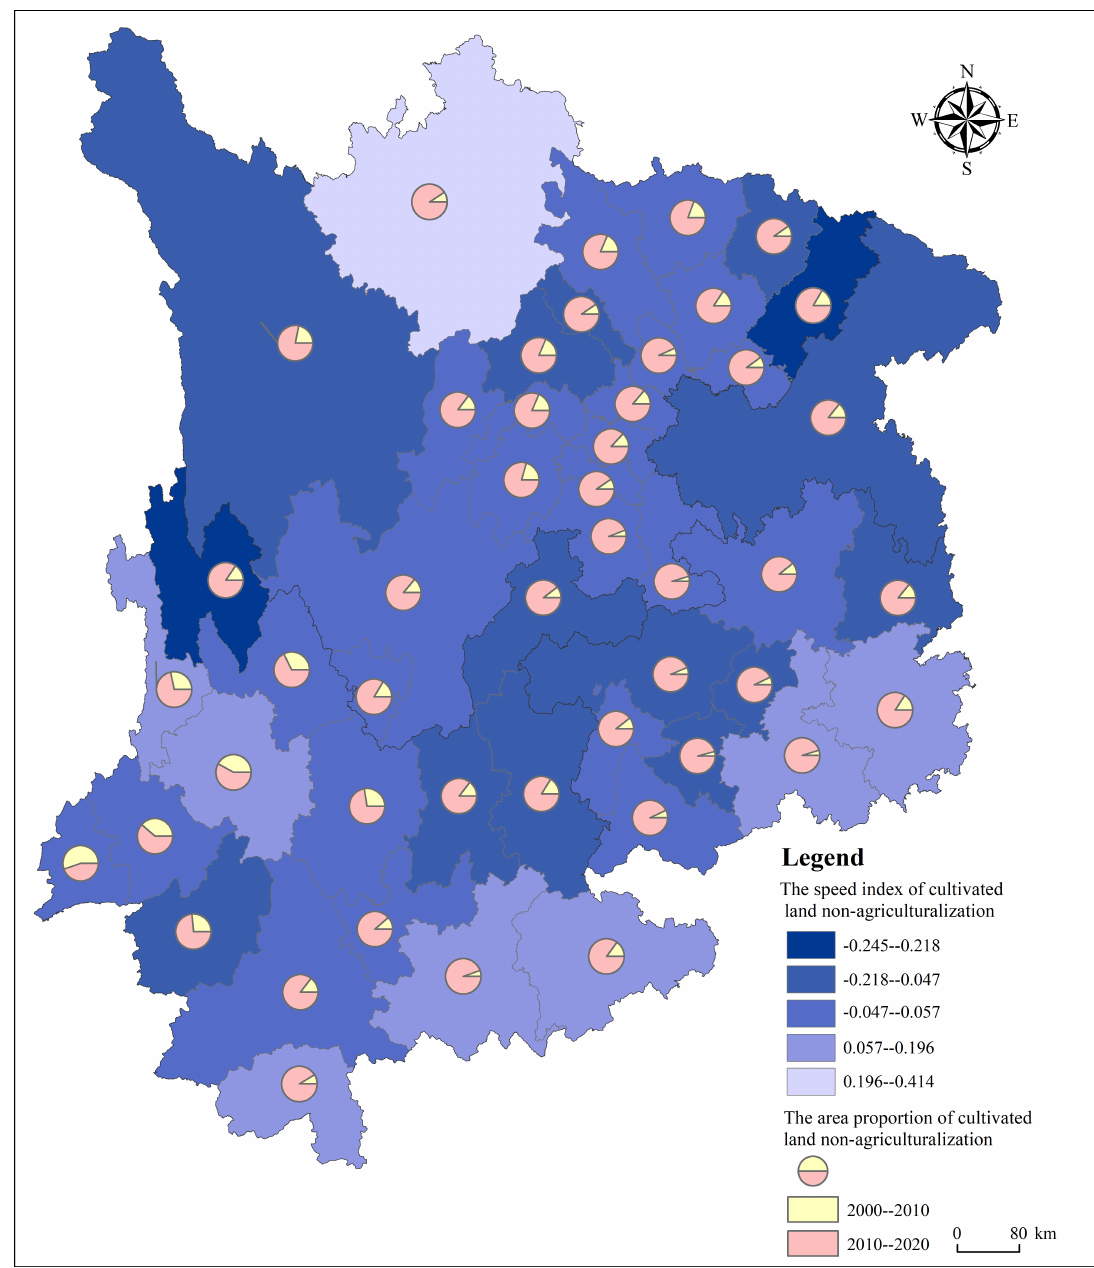
Figure 5. Map of the speed index for cultivated land